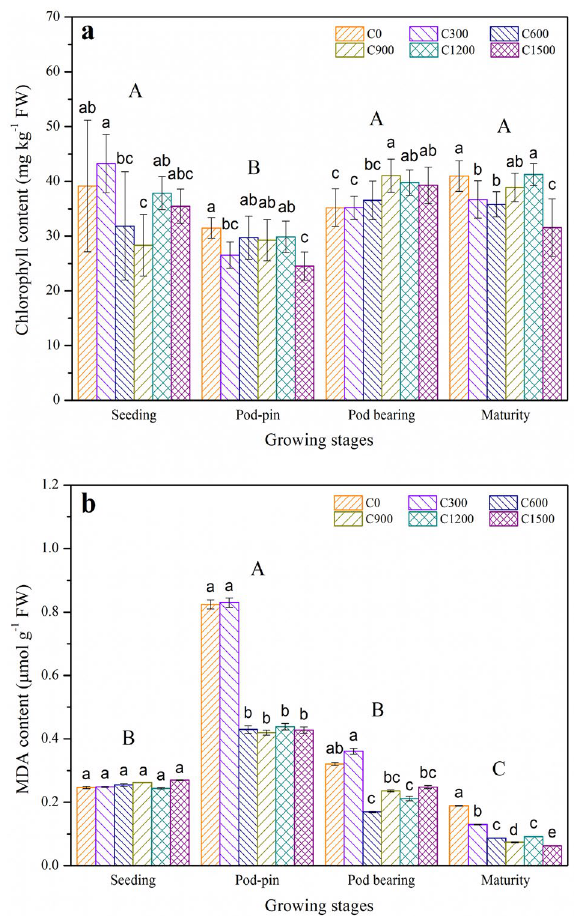
Figure 3. Effects of slaked lime application on the contents of ( a ) chlorophyll and ( b ) malondialdehyde (MDA) in peanut leaves. The values are means (± SD) of three replicates. Bar groups with different capital letters indicate significant differences ( p < 0.05) among the growth stages. Bars with different lowercase letters indicate significant differences ( p < 0.05) among the six slaked lime treatments for the same growth